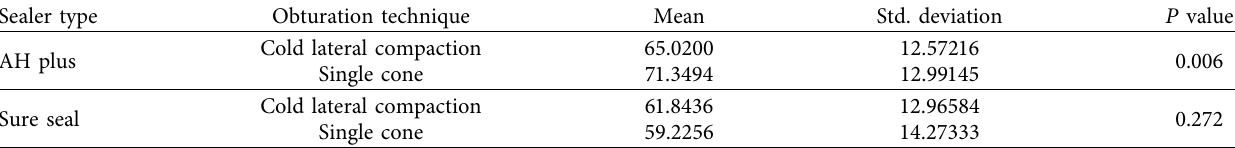
Table 3: Efect of obturation technique on the mean percentage of gutta-percha based on the two sealer types (independent samples t -test). Sealer type